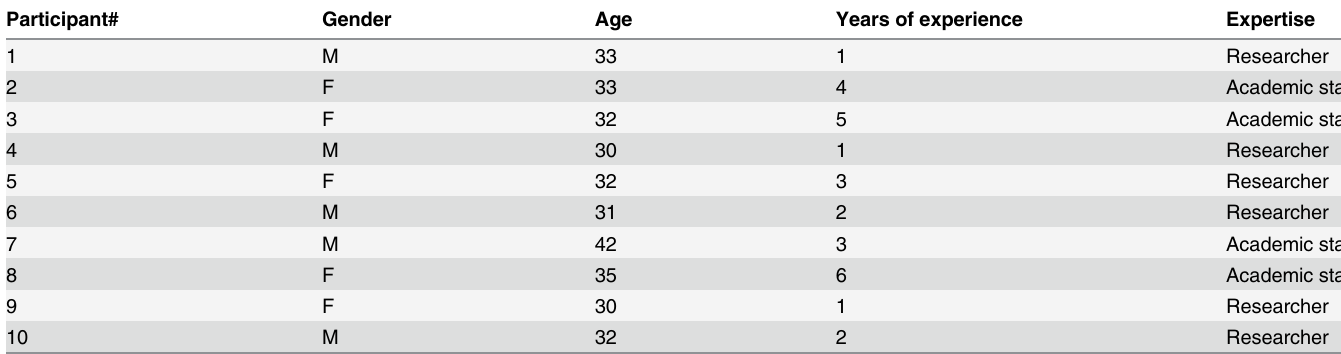
Table 7. Demographic information of